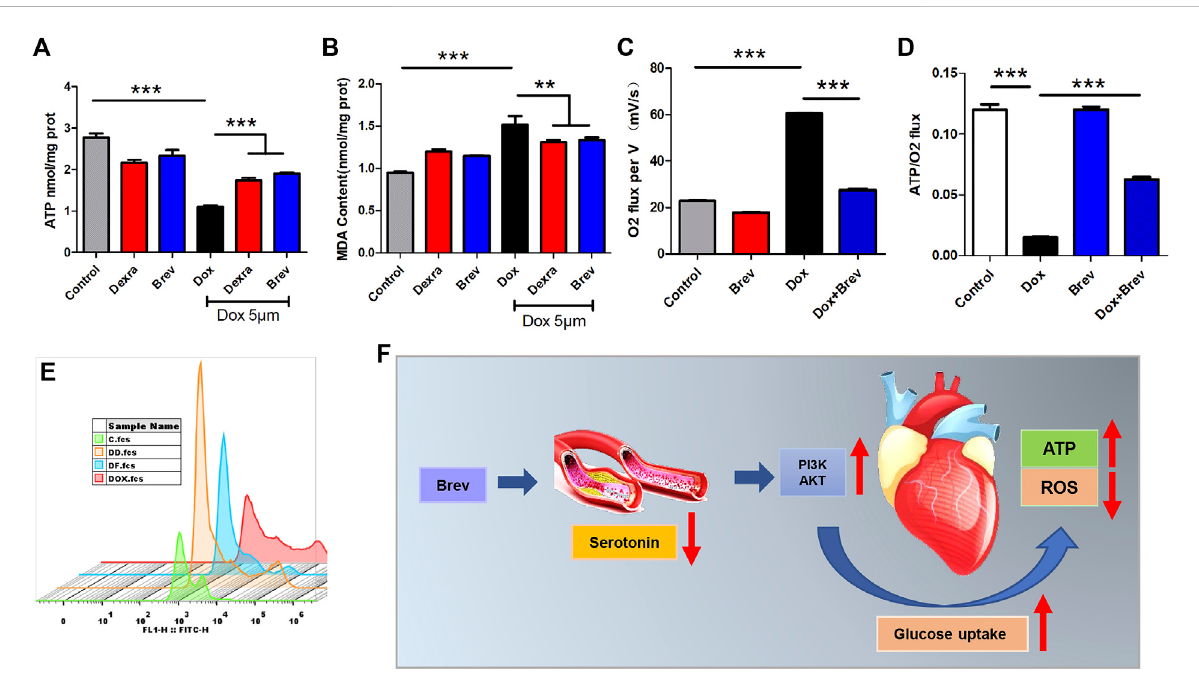
FIGURE 5 (A) ATP content in H9c2 cells. (B) MDA content in H9c2 cells. (C) Cardiac oxygen consumption in H9c2 cells. (D) The ATP production/oxygen consumption ratio in H9c2 cells. (E) The intensity of ROS staining in H9c2 cells. (F) Schematic diagram. Control vs. Dox, Brev vs. Dox, and Dexra vs. Dox: *** p < 0.0005, ** p < 0.005, * p < 0.05, mean ± SD. n = 6 –